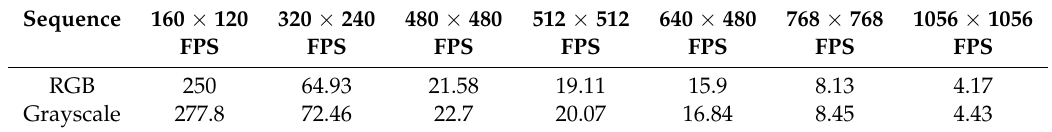
Table 5. System average time measures in FPS, using the ZedBoard (CPU+FPGA). Sequence